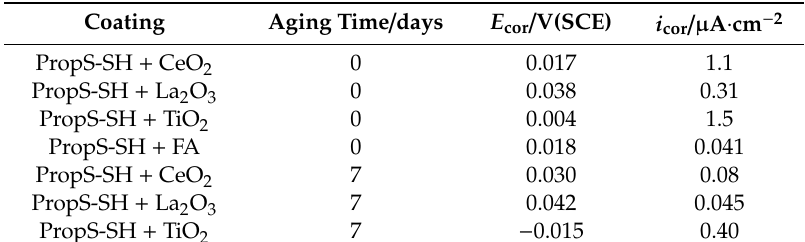
Table 4. Corrosion potentials ( E cor ) and corrosion current densities ( i cor ) obtained on particle-containing PropS-SH coatings after 20 days of immersion in AR × 10 at 30 ◦ C. η corresponds to the increase in protection e ffi ciency a ff orded by particle charging.